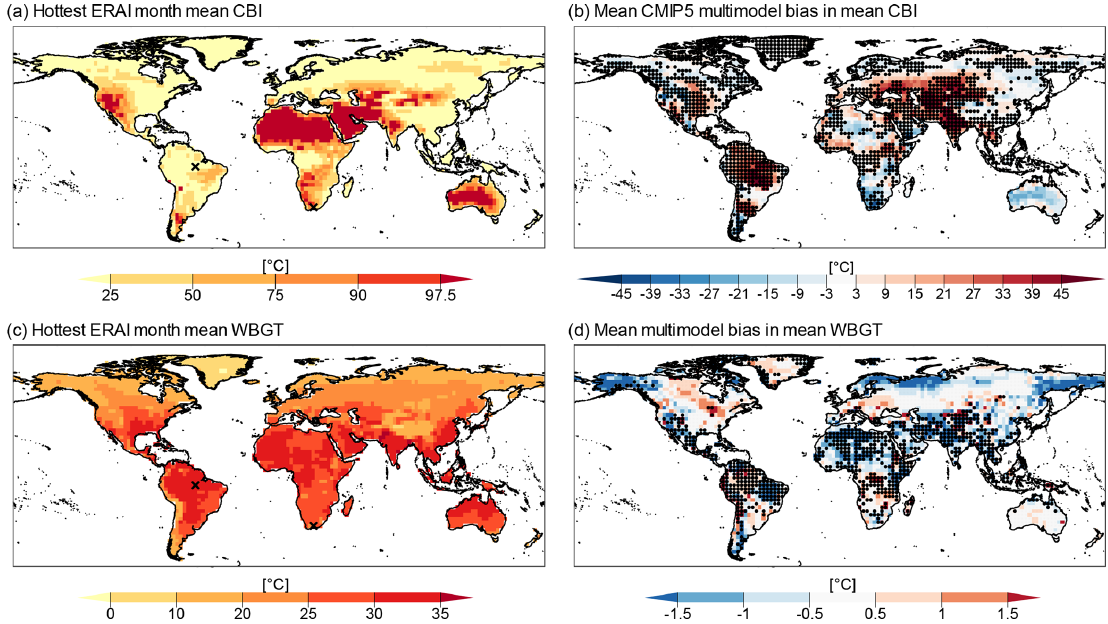
Figure 2. Mean fire hazard index (CBI) value for ERA-Interim (a) , and mean multimodel bias in mean CBI (b) . Note that the palette is non-linear, as it follows typical defined ranges of fire hazard levels based on the CBI, i.e. very low, low, moderate, high, very high, and extreme. Mean heat stress index (WBGT) value for ERA-Interim (c) , and mean multimodel bias in mean WBGT (d) . Stippling indicates locations where at least 75% of CMIP5 models failed the AD two-sample test between the CMIP5 and ERA-Interim distributions of CBI and WBGT. Bias was calculated as (CMIP5 minus ERA-Interim).